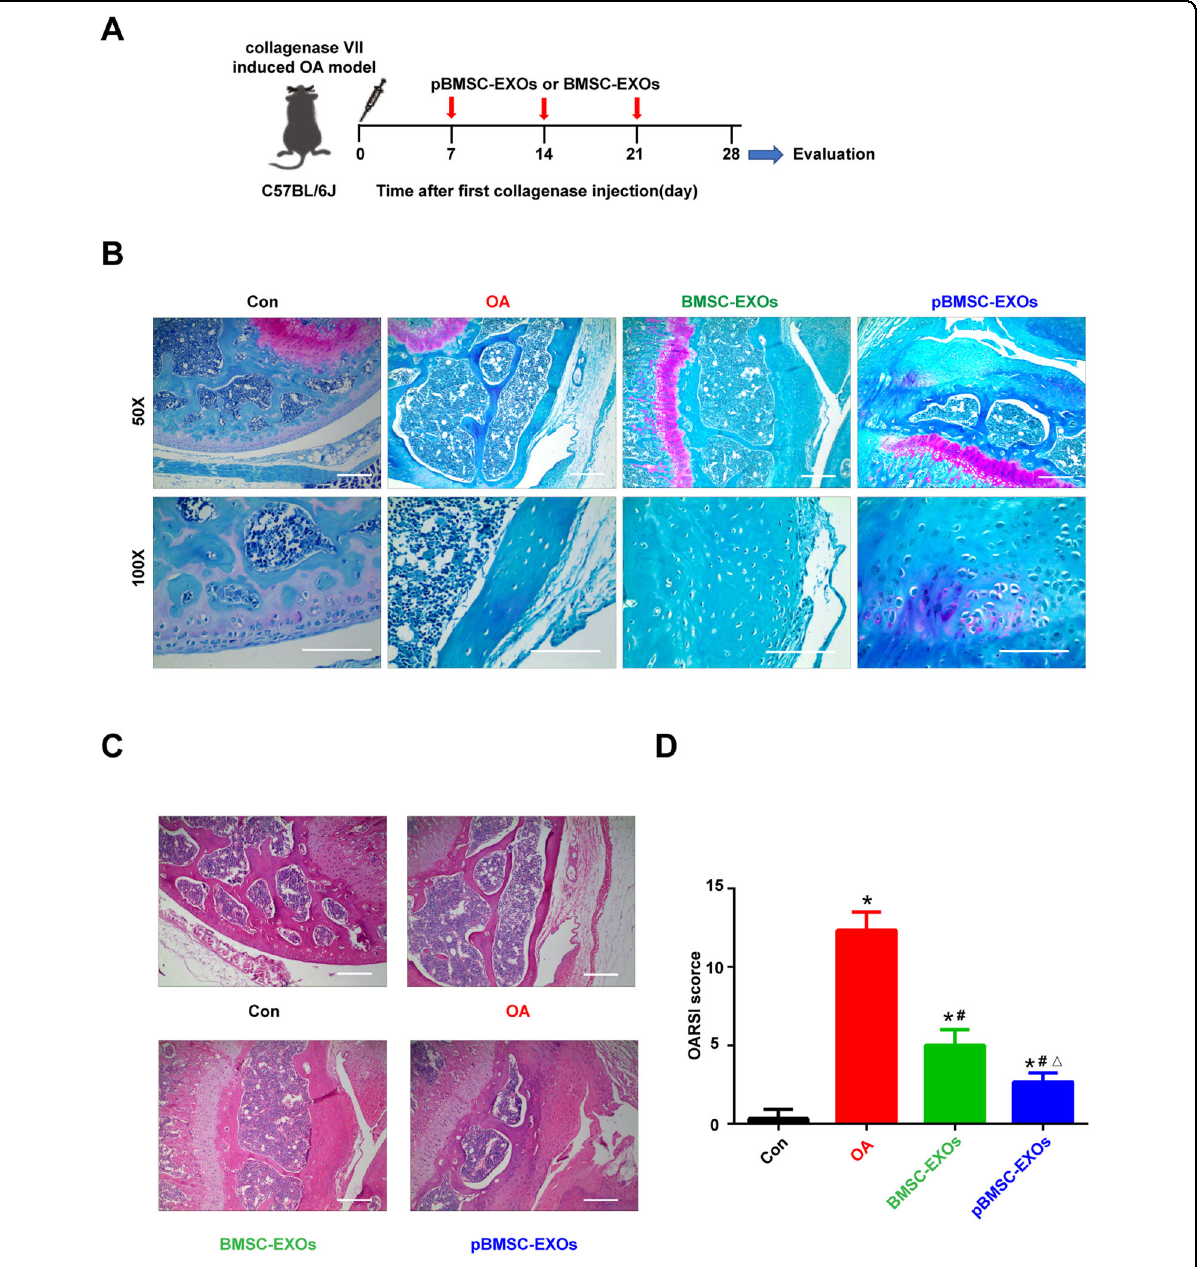
Fig. 6 Exosomes secreted by the pBMSCs for the treatment of osteoarthritis. A Flowchart of the in vivo experiment. B Safranin O/fast green staining. Scale bars, 100 μ m. C H&E staining. Scale bars, 100 μ m. D OARSI scores of the OA, BMSC-EXO, and pBMSC-EXO groups were signi fi cantly higher than those of the control (Con) group, ** P < 0.01. The scores of the BMSC-EXO and pBMSC-EXO groups were signi fi cantly lower than those of the OA group, ## P < 0.01. Furthermore, there was a signi fi cant difference between the BMSC-EXO and pBMSC-EXO groups, △ P <